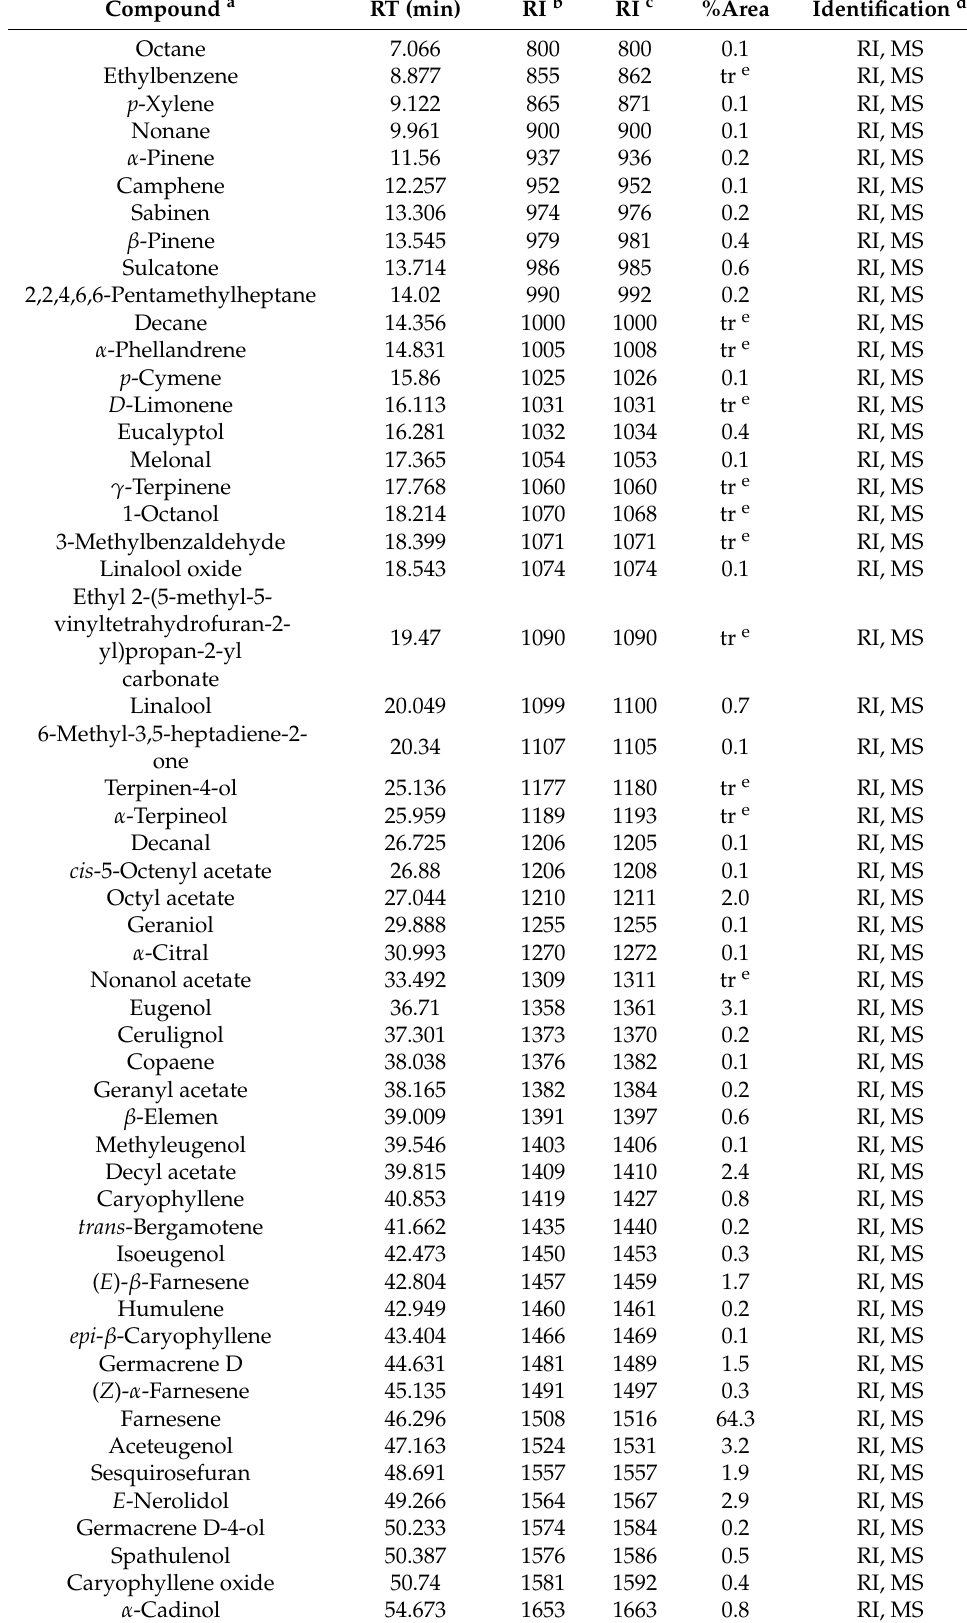
Table 1. Chemical compounds of the essential oil from A. galanga